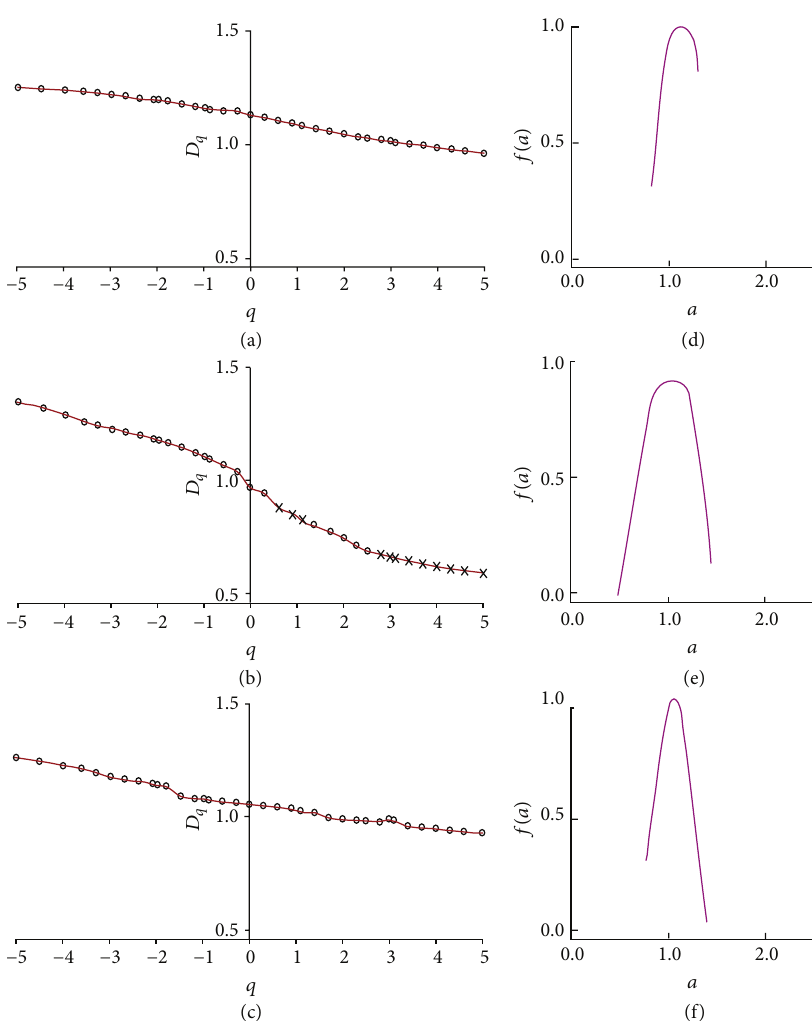
Figure 2: The three variation stages of the generalized dimension spectrum and singularity spectrum before 9 July 1979 Liyang earthquake (M6.0). (a) and (d) show the generalized dimension spectrum and singularity spectrum two years prior to this earthquake, respectively; (b) and (e) show the generalized dimension spectrum and singularity spectrum fifteen months prior to this earthquake, respectively; (c) and (f) show the generalized dimension spectrum and singularity spectrum eight months prior to this earthquake, respectively. The curve of the generalized dimension spectrum in Figure 2(b) is steeper than the two others, and the value range of the singularity spectrum in Figure 2(e) is broader than the two